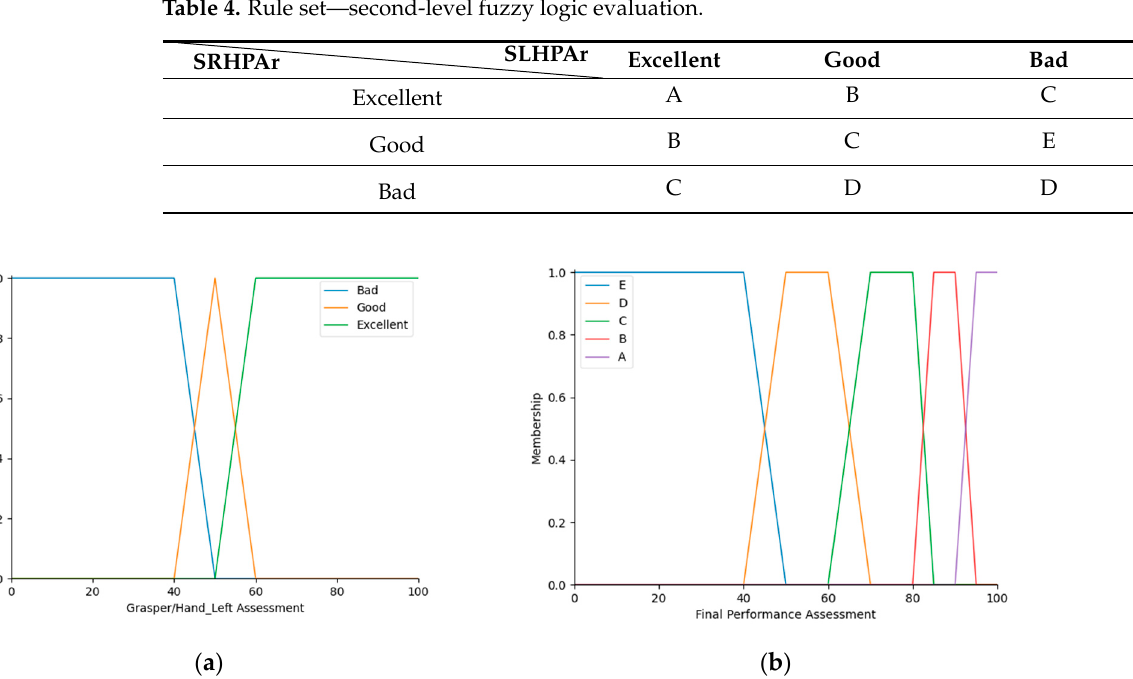
Table 4. Rule set—second-level fuzzy logic evaluation.